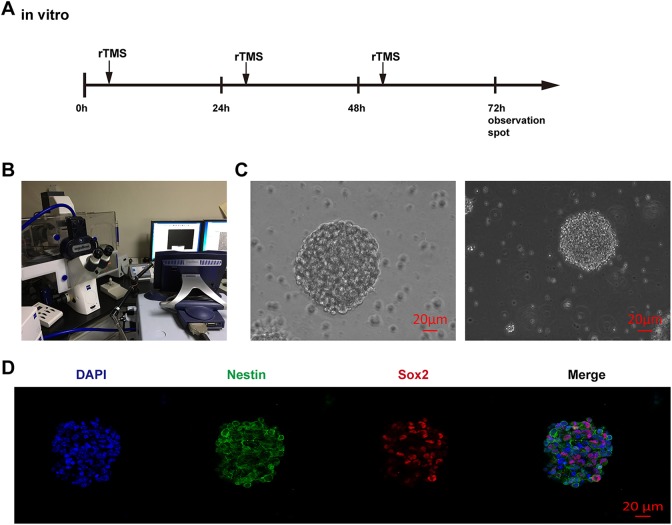
Identification of NSCs. (A) Scheme and schedule of the in vitro experiment; (B) in
vitro rTMS of NSCs; (C) Neurospheres observed under light microscopy. Scale bar = 20
μm; (D) immunocharacterization of NSCs, red: SOX2, green: Nestin, blue: DAPI, Scale
bar = 20 μm.